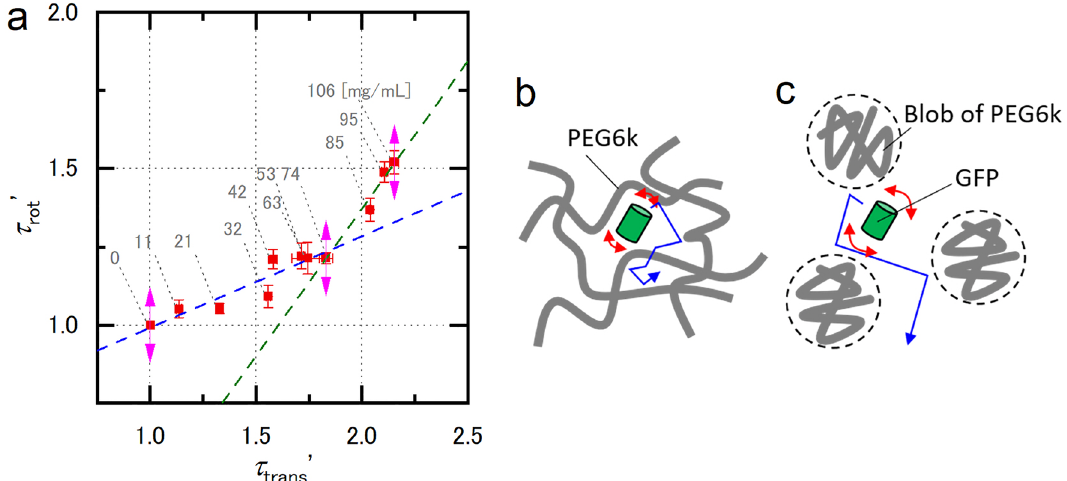
Figure 4. Results of PEG6,000 around its overlap concentration (Estimated c * was 79 mg/mL). ( a ) Comparison between the relative translational and rotational diffusion times normalized by these values of GFP solution in PBS. The error bars show standard deviations ( n = 3). Pol-FCS measurement for 30 s was repeated 10 times. The excitation laser power was 6.5 µW (3.3 kW/cm 2 ) at the samples. The concentrations of each sample at each data point were 0, 11, 21, 32, 42, 53, 63, 74, 85, 95, and 106 mg/mL in order from point (1, 1) for each crowder. The blue broken line and green broken line show the linear regression lines in the range of 1.00 ≤ τ ′ trans ≤ 1.83 and 1.83 ≤ τ ′ trans ≤ 2.15 , respectively. The blue broken line is τ ′ rot = 0.29 τ ′ trans + 0.70 . The green broken line is τ ′ rot = 0.94 τ ′ trans − 0.51 . ( b ) Schematic diagram of the estimated nano-environment in the sample with concentration lower than c *. ( c ) Schematic diagram of the estimated nano-environment in the sample with concentration higher than c *. Red and blue arrows show the rotation and translation of η ′ = τ ′ = rot trans (7) τ η 0